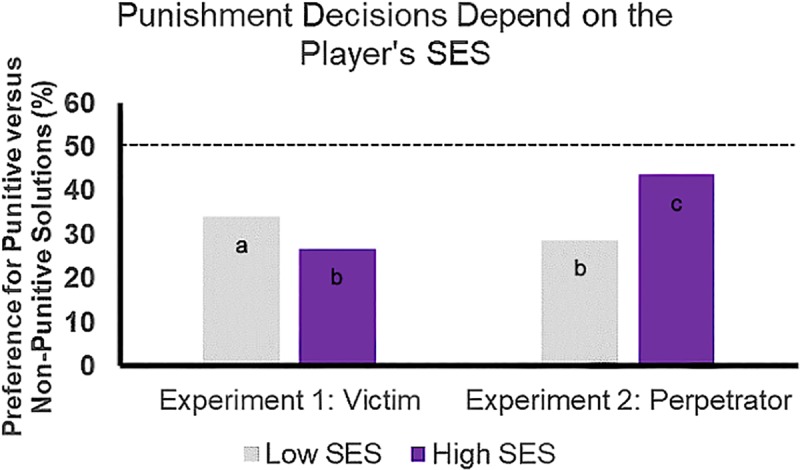
Formal comparison of decisions to punish between experiments.SES differentially shaped punishment decisions depending on whether SES varied for the recipient (Experiment 1) or the allocator (Experiment 2). For ease of interpretation, percentages from the raw count data are plotted rather than fitted log odds ratios. For this reason, error bars are not included in this figure. Independent of offer inequity, percentages of decisions to punish (vs. not punish) selfish offers are plotted as a function ascribed SES level (i.e., low, high) and experiment (i.e., Experiment 1, Experiment 2: total n = 999). Significant simple effects are indicated by distinct letters (i.e., c > a > b), all p < .05. See Table 5 for full contrast statistics. For all conditions plotted here, participants preferred non-punitive to punitive solutions, as indicated by all bars being significantly below the dotted line representing equal preference (see Table 6).